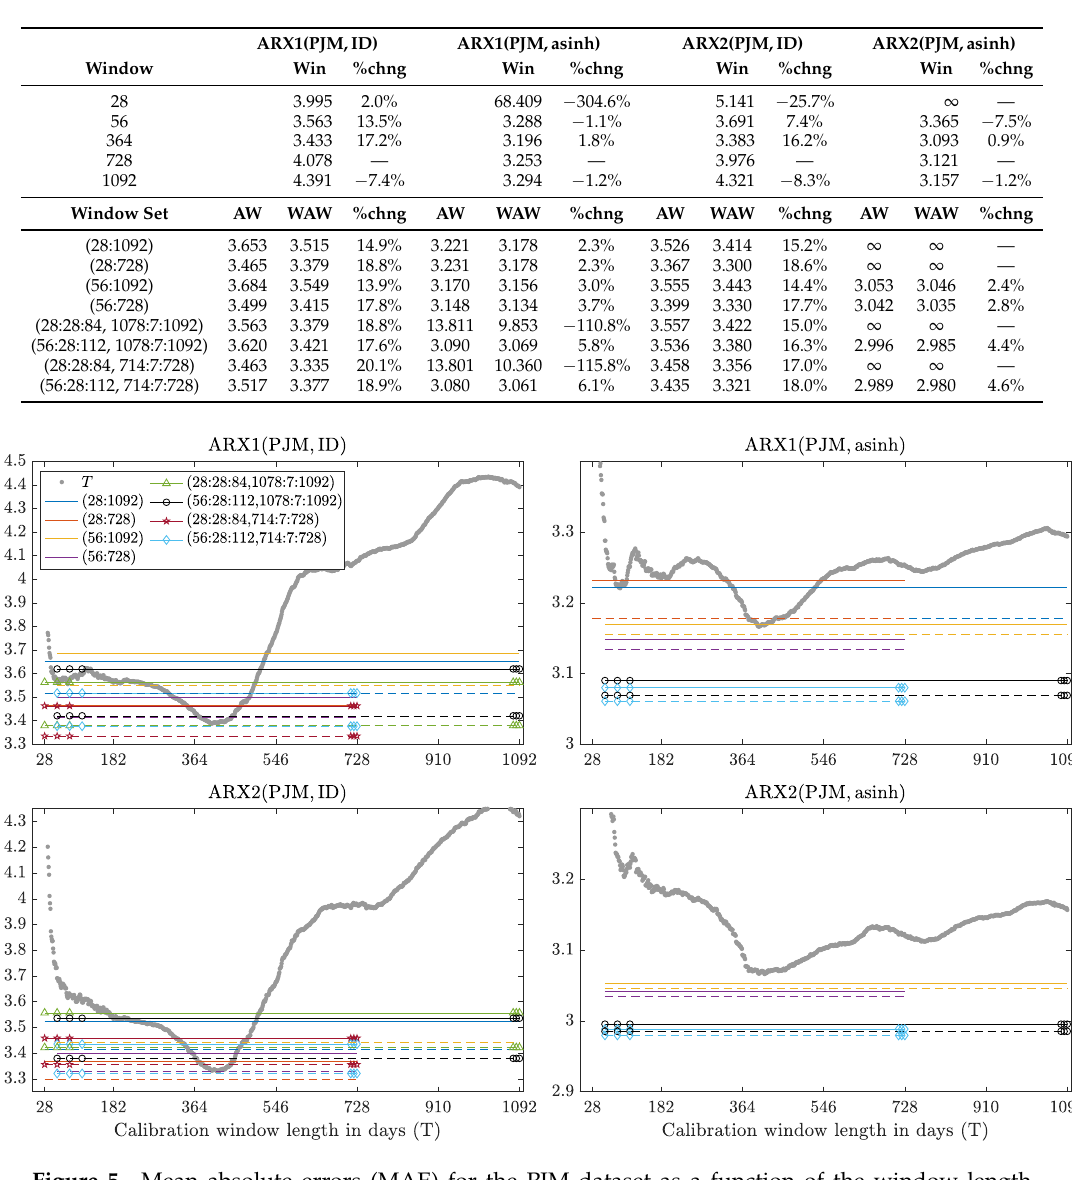
Table 2. Mean absolute errors (MAE) of the ARX1 and ARX2 models fitted to ID - or asinh -transformed PJM data for selected windows ( T ) and window sets ( T ). Relative improvements (%chng) of the Win ( T ) and WAW ( T ) forecasts with respect to Win (728) are also reported. MAEs in excess of 10 10 are denoted by ∞ ; for these values we do not provide %chng.